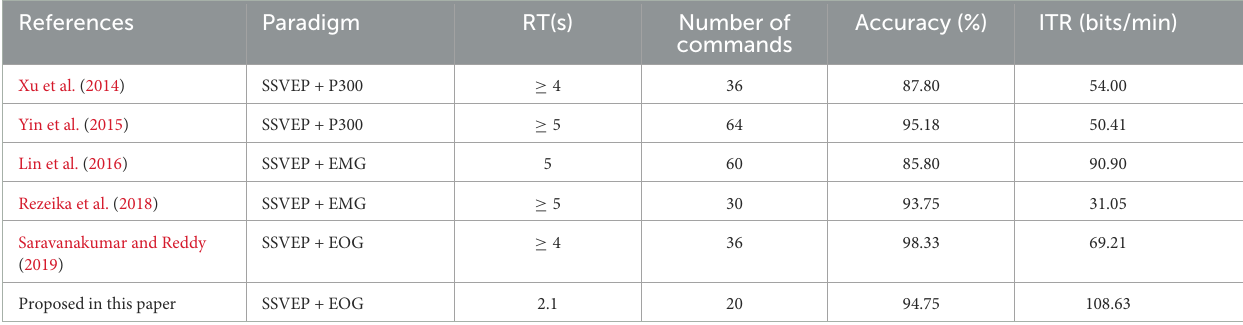
TABLE 2 Comparison between our system and several other hybrid BCI